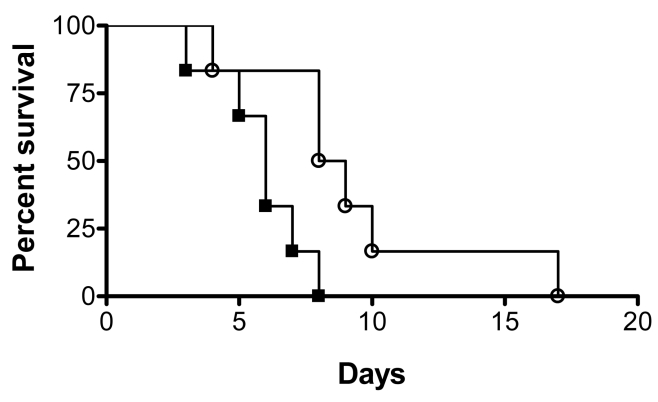
Dispersed cells display increased virulence in vivo.Groups of mice were injected with the same dose (2.8×105 CFU) of either dispersed cells from biofilms (black squares) or cells obtained from matched planktonic cultures (open circles), and their survival was monitored over the course of infection in this murine model of hematogenously disseminated canididiasis. Statistically significant differences were observed between the corresponding survival curves generated for the two groups of mice (P<0.05).